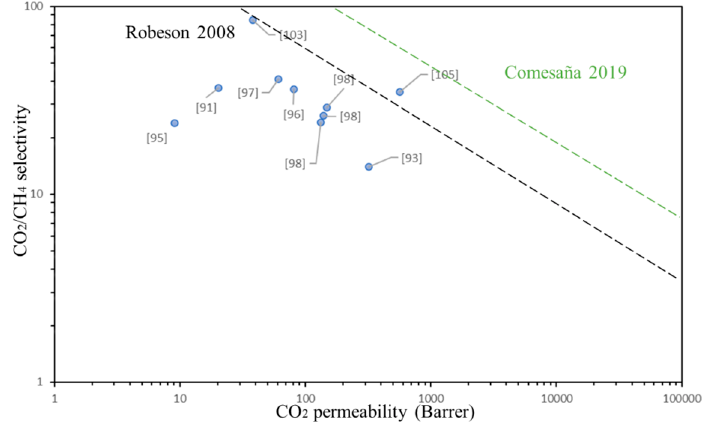
Figure 5. Upper bound correlation for CO 2 /CH 4 separation.